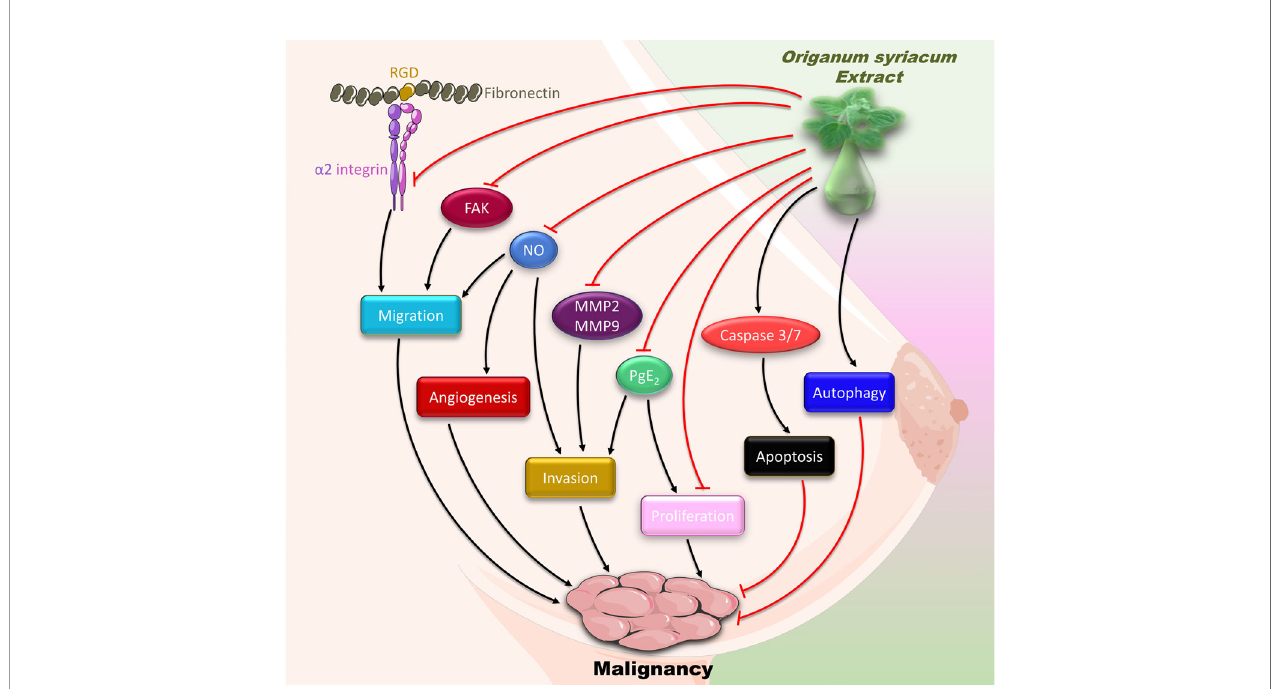
FIGURE 9 | Summary of the anti-malignant mechanisms of OSE in MDA-MB-231